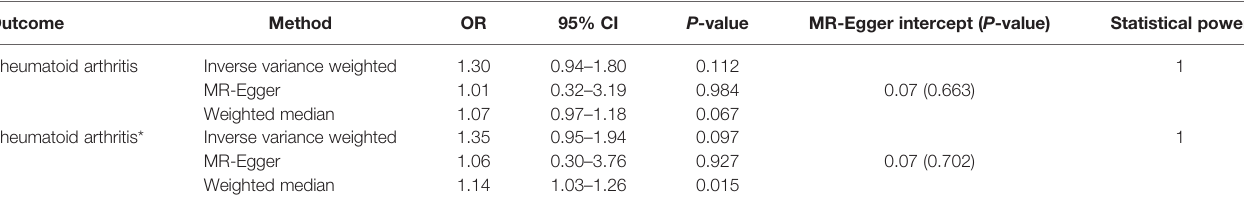
TABLE 3 | Mendelian randomization estimates of Graves ’ disease on rheumatoid arthritis.